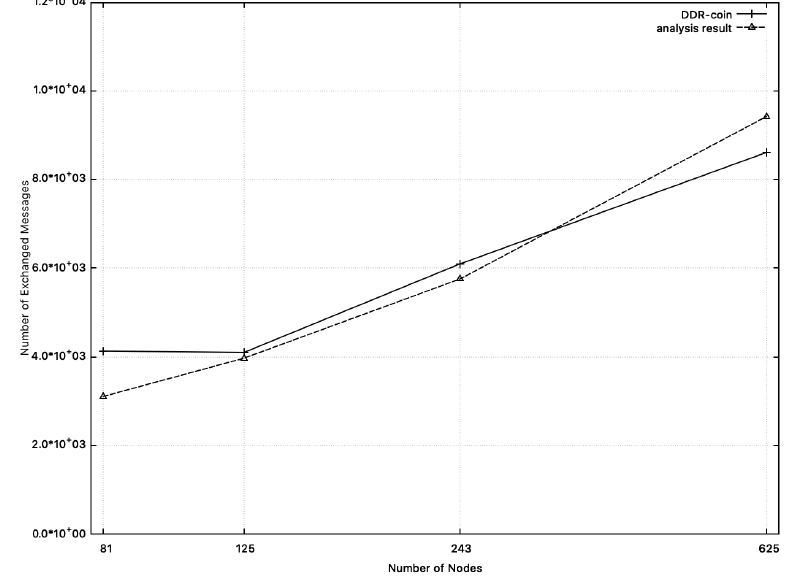
Figure 10. Message complexity: the measured numbers from simulations and the analysis results from Section 3 when k = 3 or 5, w = 10,000, and n = 3 4 ,3 5 ,5 3 ,5 4 . The solid line represents message complexity measured from simulation. The dotted line (analysis results) represents the function: ( w / n ) 35 · n log n